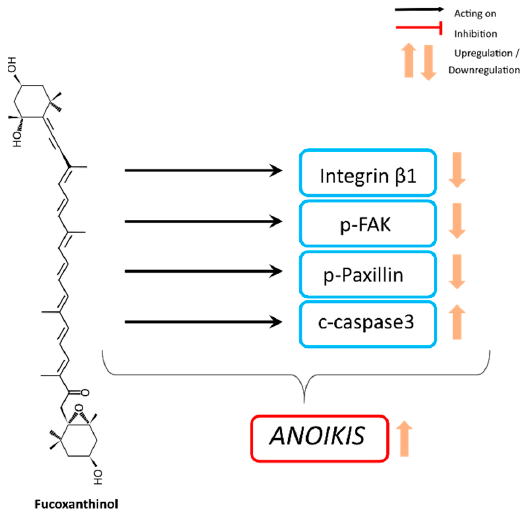
Figure 5. Anoikis induction by fucoxanthinol in cancer cells.